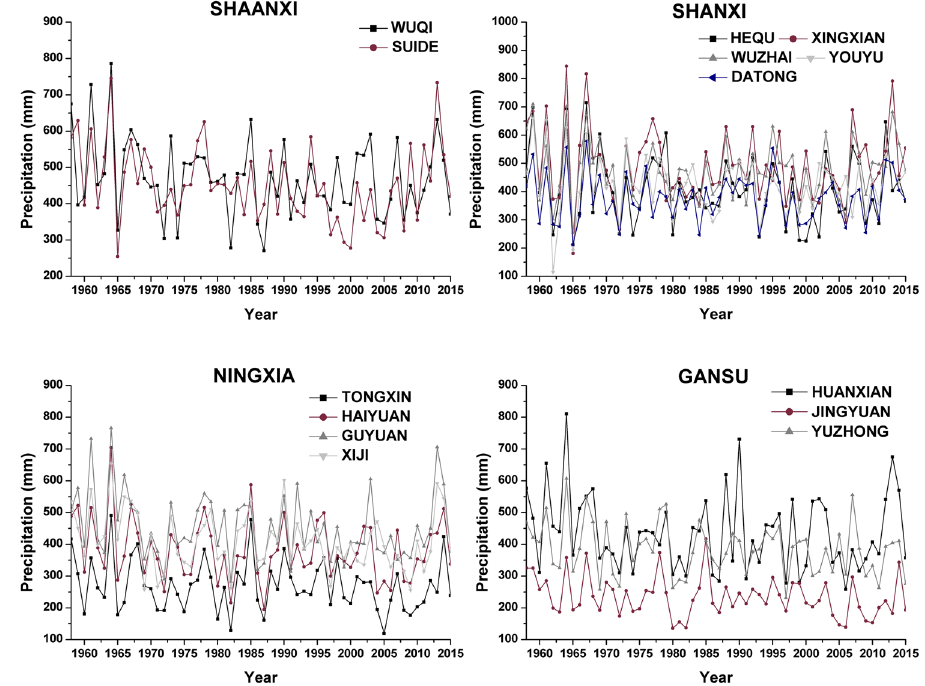
Figure 1. Time series of annual precipitation at each synoptic